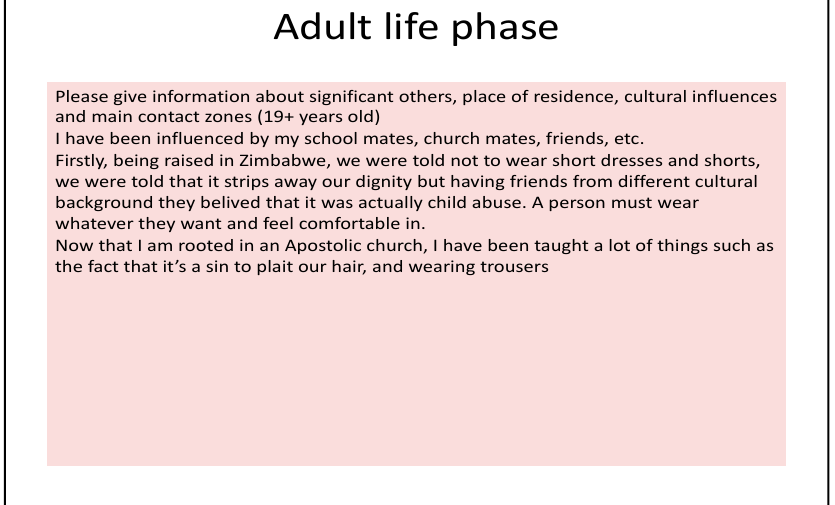
Figure 7. Tanaka’s adult life phase.